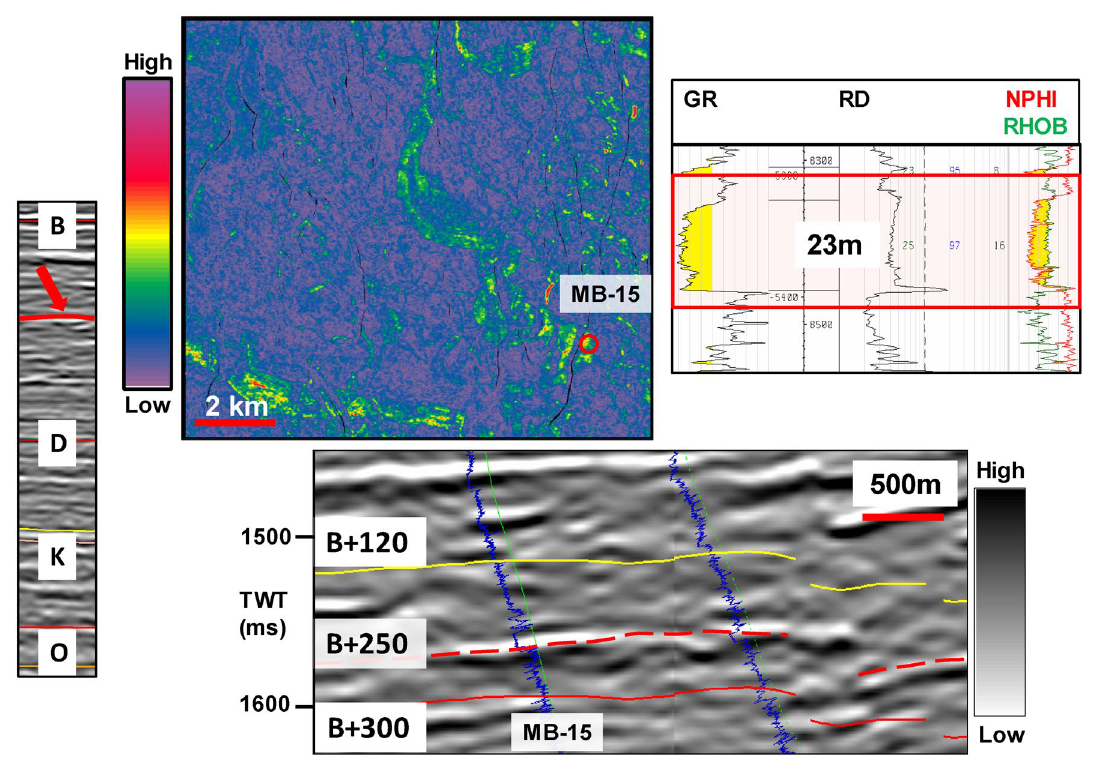
Fig. 5 The RMS amplitude map of B+250 horizon. The high ampli- tudes are aligned roughly north–south in the study area. The seismic section along well bore shows B+250 horizon pick. The well log